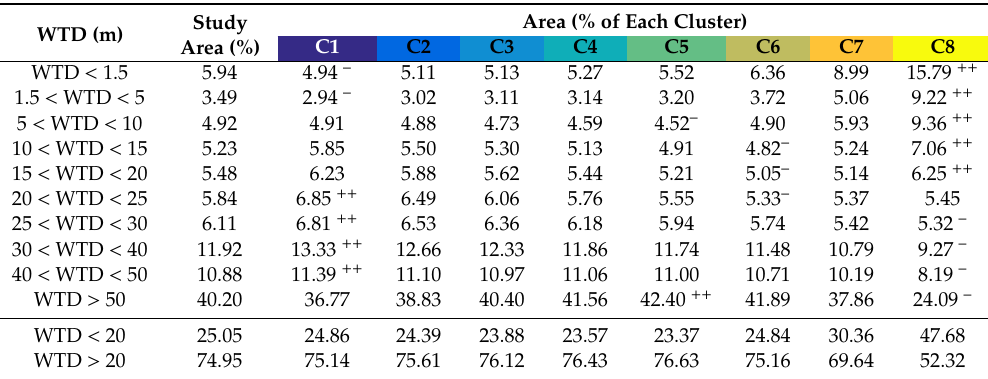
Table 5. Area of water table depth (WTD) classes occurring in the study area and in each cluster (% of the area of each cluster). ++ Denotes the largest area on each WTD interval, and – denotes the smallest. The likelihood of being GDV increases from C1 to C8.